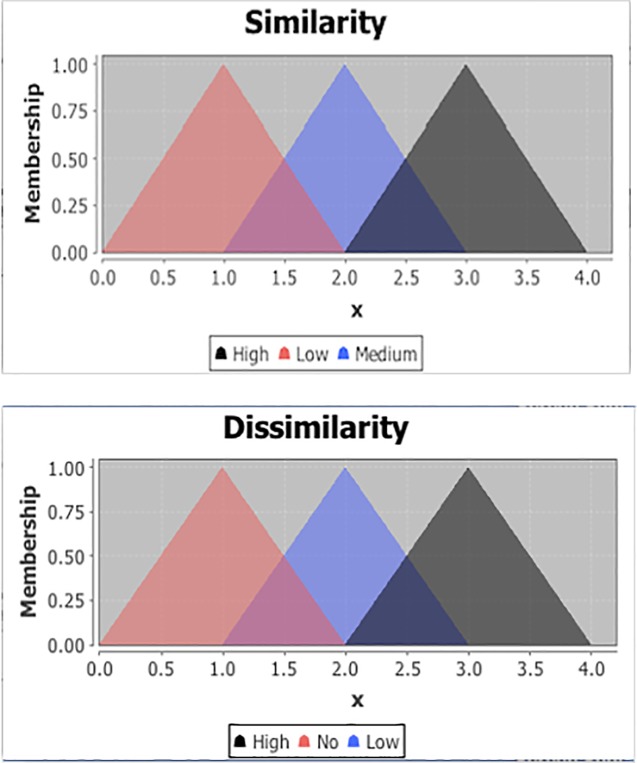
Membership function for input variable ‘similarity’ and ‘dissimilarity’.